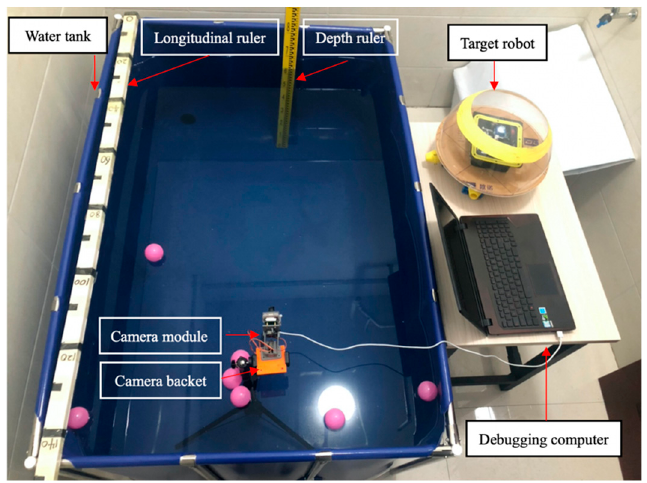
Figure 29. Experimental set up for thetarget image recognition.